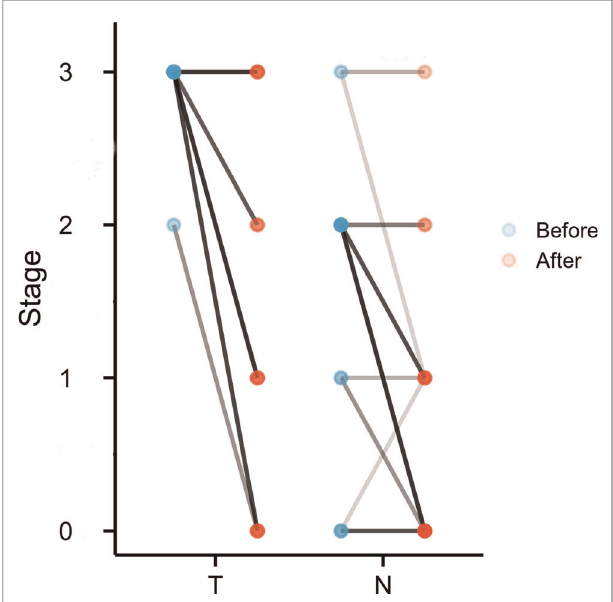
FIGURE 2 | Change in T stage and N stage before and after treatment. Colors of lines, from light to dark, re fl ect the number of patients in which stage was correlated.